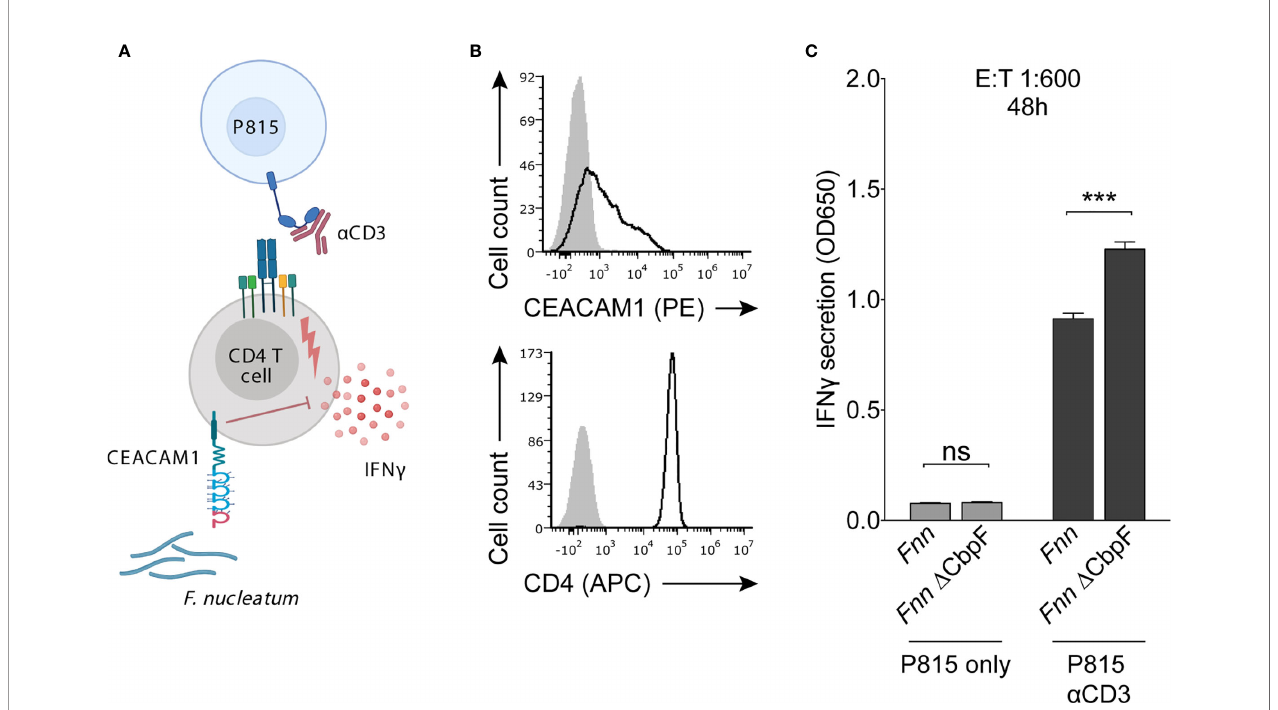
FIGURE 4 | Fnn inhibits CD4 + T cell IFN- g secretion by activating CEACAM1. (A) Schematic representation of the redirected cytokine assay. Mouse mastocytoma P815 cells expressing Fc g R were coated with anti-CD3 to enable activation of T cells and subsequent IFN- g secretion. Cells were incubated with Fnn or the Fnn Δ CbpF mutant at a E:T ratio of 1:600 and IFN- g secretion was quanti fi ed by ELISA after 48 hours of incubation. (B) Flow cytometry staining of primary IL-2 activated human CD4 + T cells with anti-CEACAM1 and anti-CD4. Filled grey histograms represent staining with secondary antibody only. (C) Quanti fi cation of IFN- g secretion determined by ELISA. Bars represent means of triplicates ± SD. The graphs represent data collected from two independent experiments. Statistical signi fi cance was assessed using a two-tailed unpaired t test. ***p ≤ 0.001. NS, not signi fi